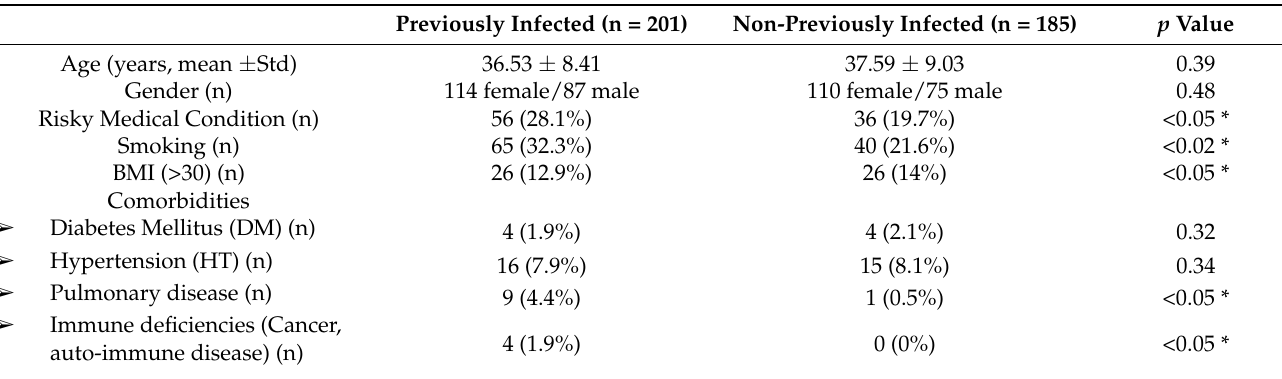
Figure 1. Graphical abstract of the study and the subgroups included (PI = previously in- fected, NPI = non-previously infected, PIBB = previously infected BioNTech booster receiver, PICB = previously infected CoronaVac booster receiver, PINB = previously infected non booster receiver, NPIBB = non-previously infected BioNTech booster receiver, NPICB = non-previously in- fected CoronaVac booster receiver, NPINB = non-previously infected non booster receiver groups, n = number of the participants, GMT = geometric mean of anti-SARS-CoV-2 spike total Ab (GMT of NAb Wuhan ; GMT of NAb Omicron ). Table 1. Demographic data of participants included in the